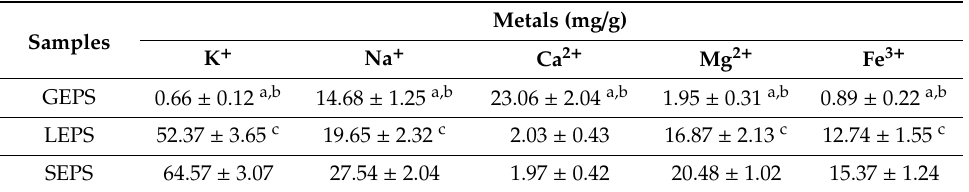
Table 2. Composition and amounts of metals in EPSs.